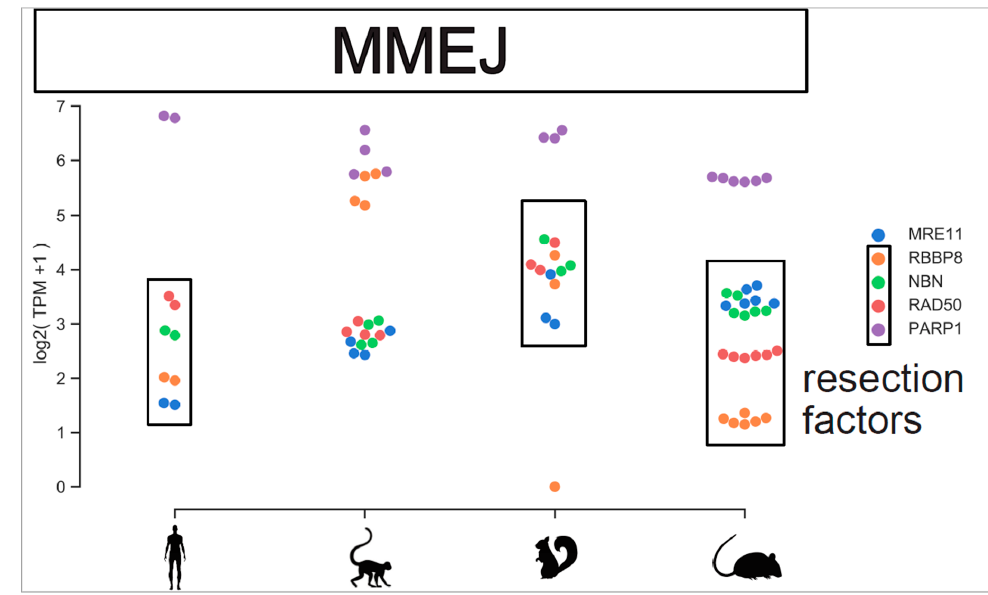
Figure A4. MMEJ repair components viewed across species. Expression level of MMEJ resection factors and PARP1 are plotted across species. Gene expression level are plotted individually for each